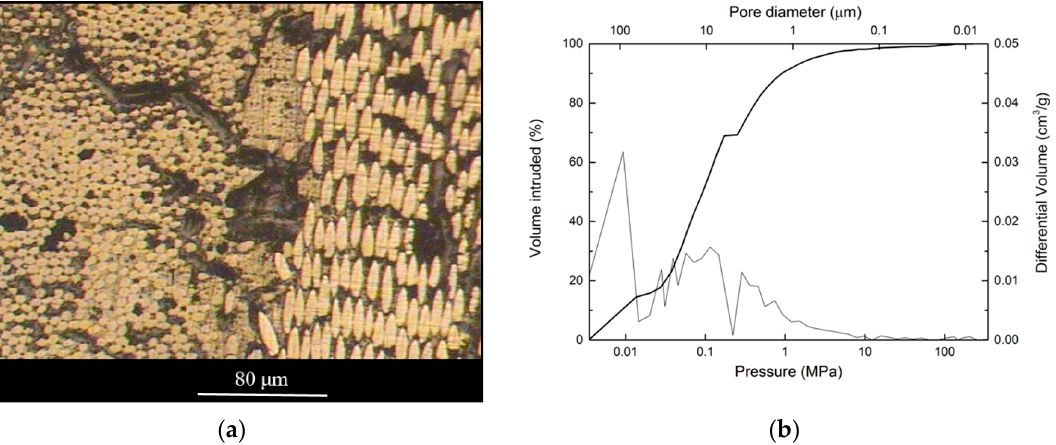
Figure 4. ( a ) Optical microscopy image of a polished cross-section of the C f /C preform; ( b ) mercury intrusion curve as a function of pressure and pore size distribution for the C f /C preform.